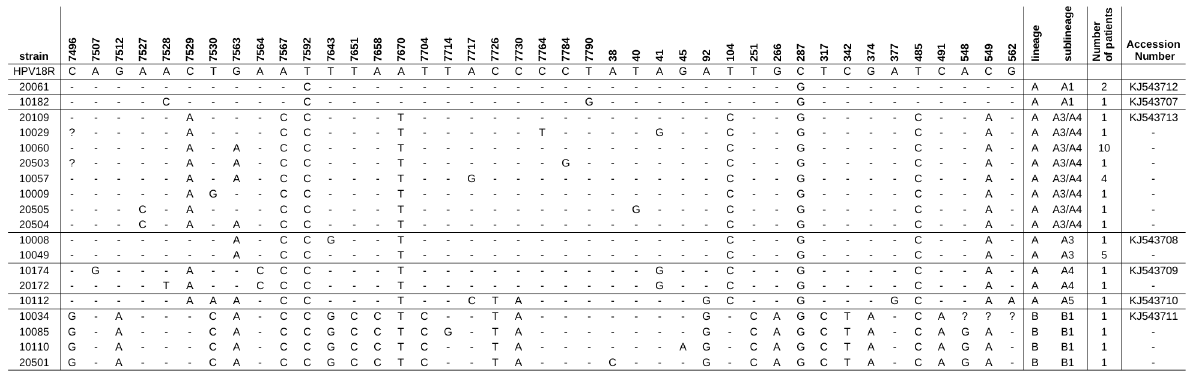
Figure 4. Nucleotide sequence variations of LCR/E6 among HPV18 isolates. Position number refers to the HPV18 prototype sequence previously described [18].